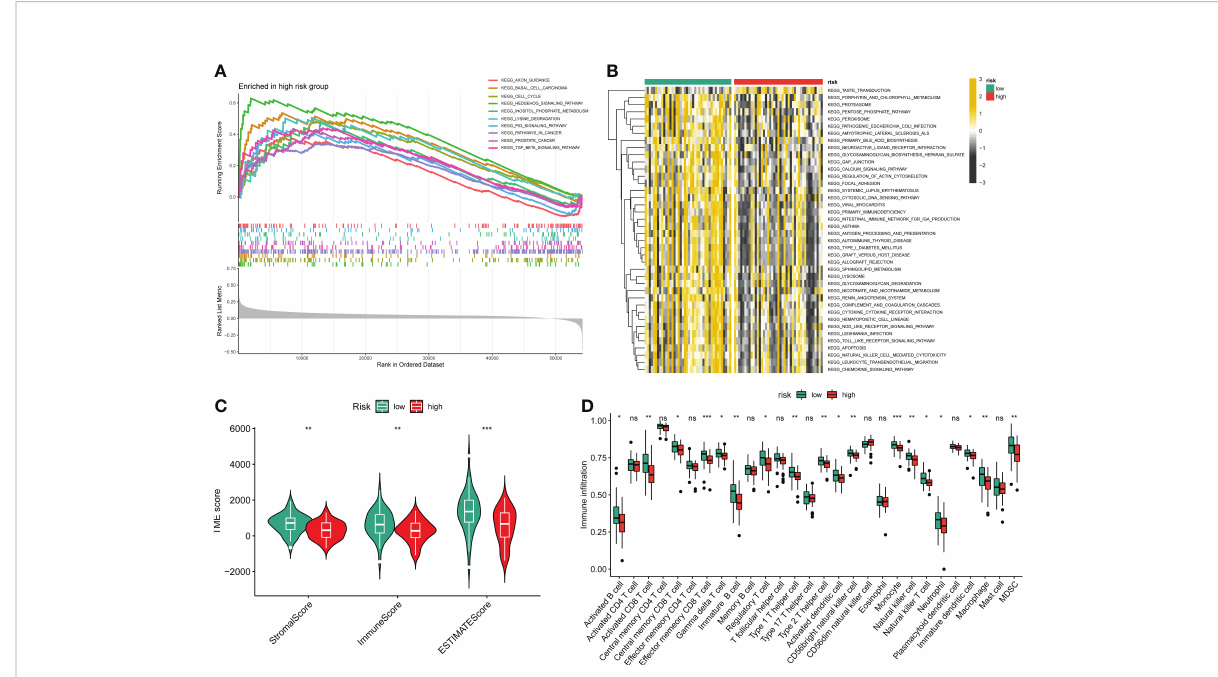
FIGURE 6 The relationship between the novel CRLs signature and tumor immune microenvironment in OS. (A) The GSEA between the two distinct risk groups. (B) The heatmaps of GSVA displayed signaling pathways between the high-risk and low-risk groups. (C) The TME score between distinct groups. (D) Box plot indicating the relative abundance of immune cells based on ssGSEA in the distinct risk groups. *p < 0.05, **p < 0.01, ***p <